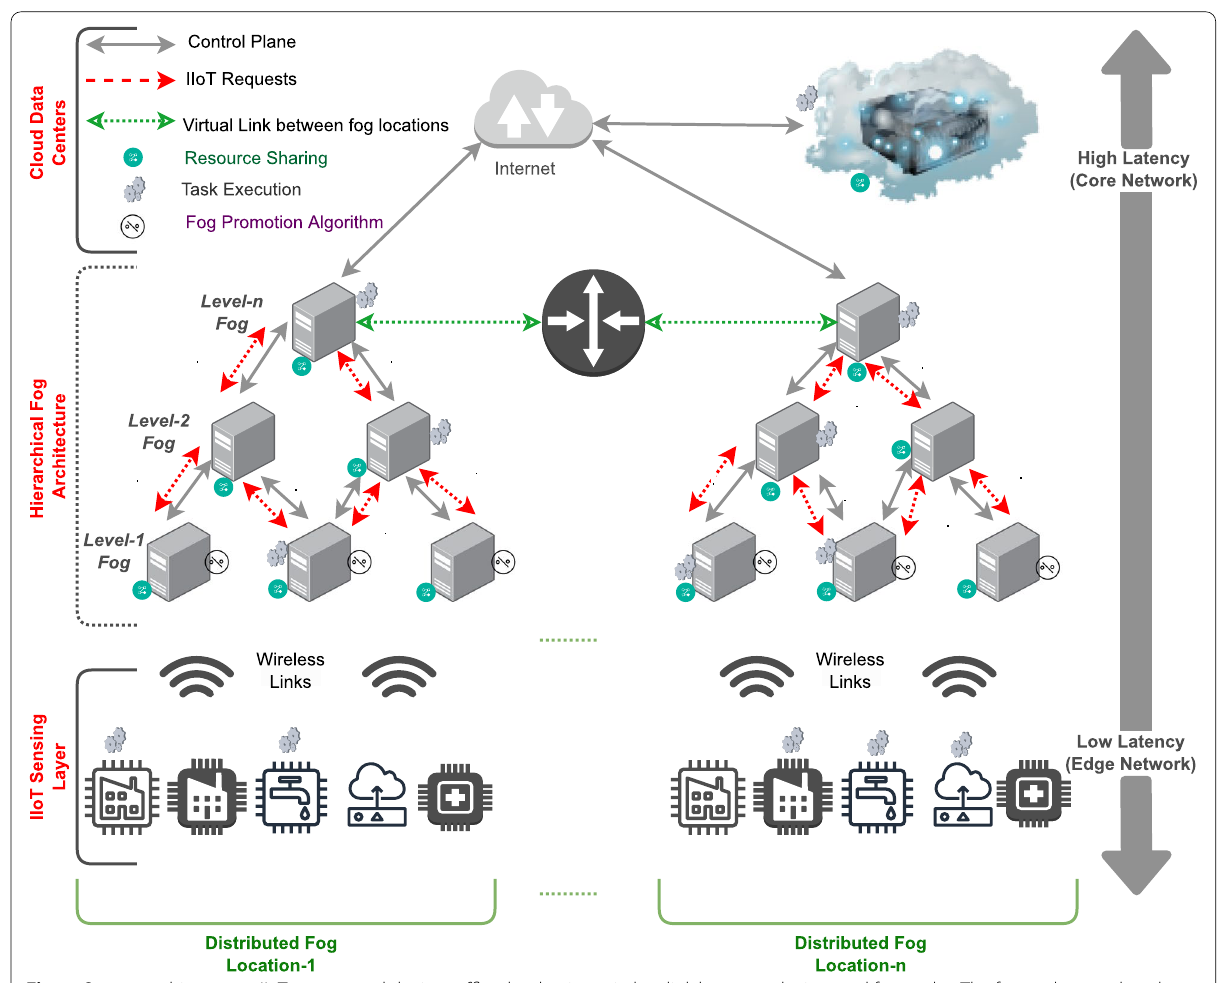
Fig. 1 System architecture – IIoT sensors and devices offload tasks via a wireless link between devices and fog nodes. The fog nodes are placed in a hierarchical model classified into multiple levels. Level-1 fog nodes are the intelligent nodes that decide whether to offload tasks to volunteer devices, same-level fog, higher-level fog, or a nearby fog